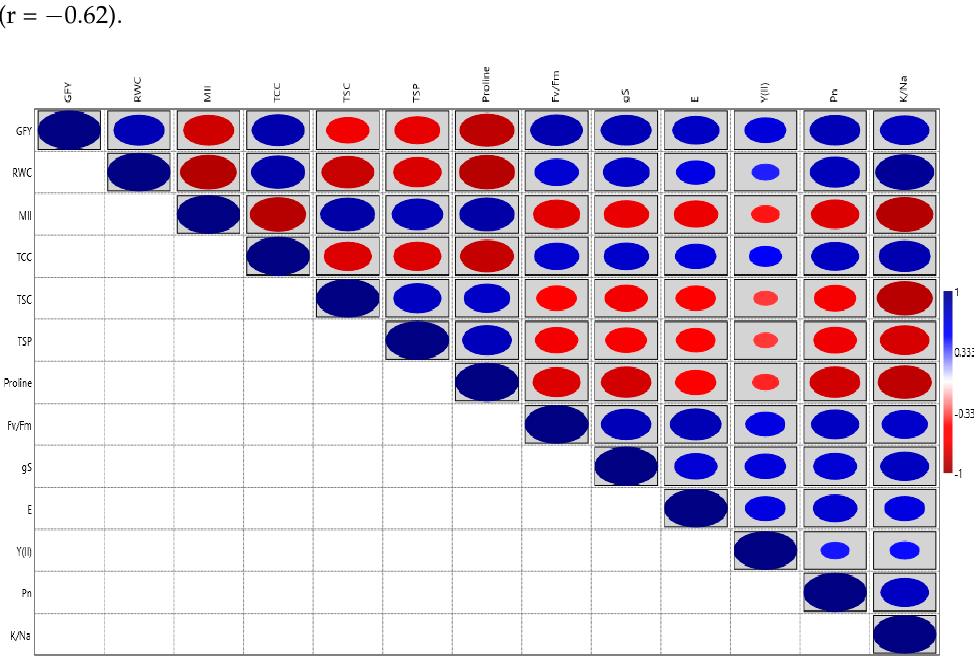
Figure 2. Relationship among green fodder yield (GFY), physiological and biochemical attributes of sorghum crop at 60 DAS; [boxed diagonal shows signi fi cant ( p ≤ 0.05) association; red and blue colour indicate negative and positive correlations, respectively]. RWC: relative water content; MII: membrane injury index; TCC: total chlorophyll content; TSC: total soluble carbohydrate; TSP: total soluble protein content; Fv/Fm: chlorophyll fl uorescence; gS: stomatal conductance; E: transpiration rate; Y (II): photon quantum yield; Pn: photosynthetic rate; K/Na: potassium to sodium ratio .